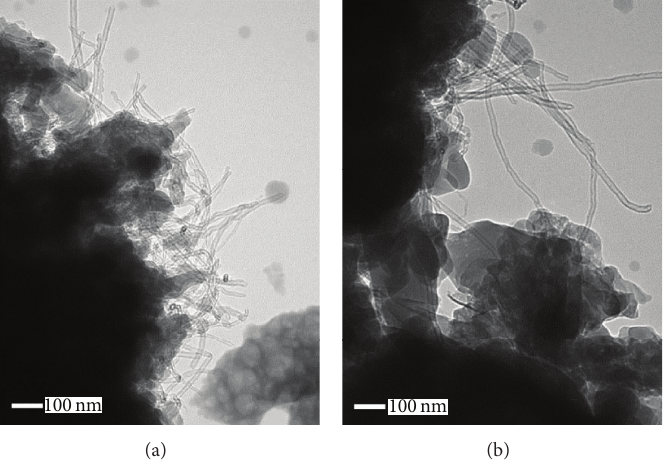
Figure 9: TEM images of short MWCNTs (a) and long MWCNTs (b) within the hardened cement paste [95].